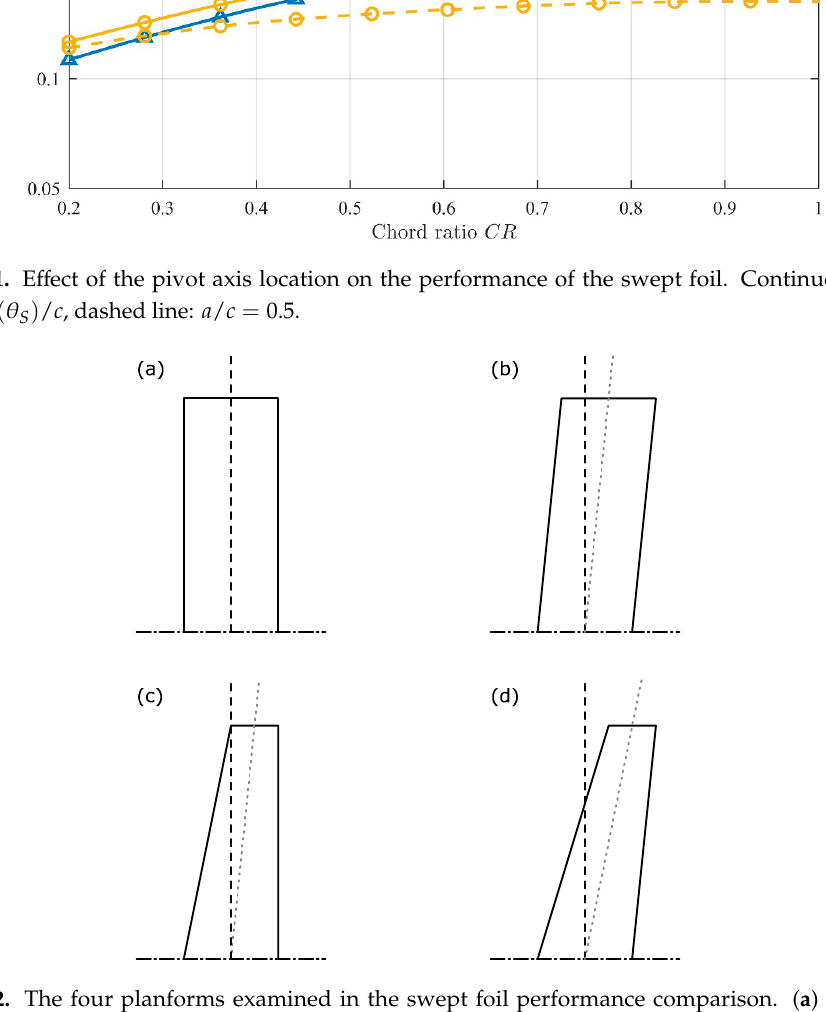
Figure 11. Effect of the pivot axis location on the performance of the swept foil. Continuous line: